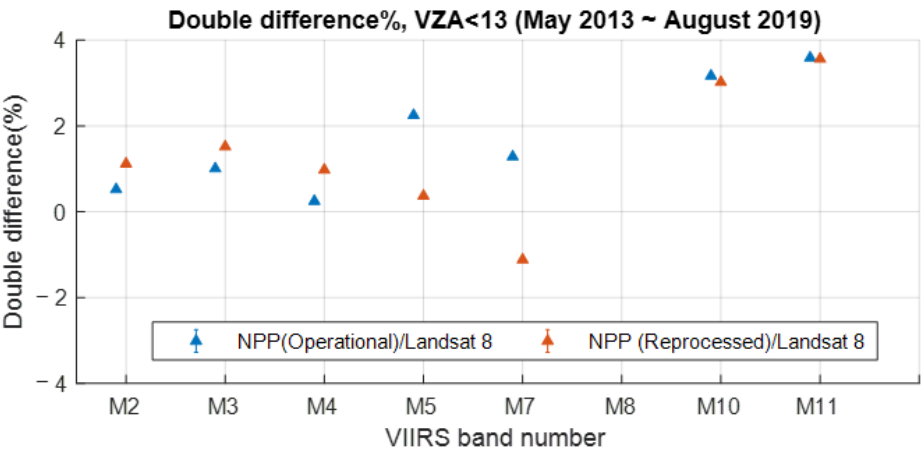
Figure 6. The double difference in the reflectance ratio percentage between SNPP/VIIRS operational and reprocessed data and Landsat 8/OLI via RadCalNet at RVUS from May 2013 to August 2019. Table 4. The mean and standard deviation of the reflectance ratio percentage between Landsat 8/OLI with operational and reprocessed SNPP/VIIRS at RVUS from May 2013 to August 2019. SNPP VS. Landsat 8